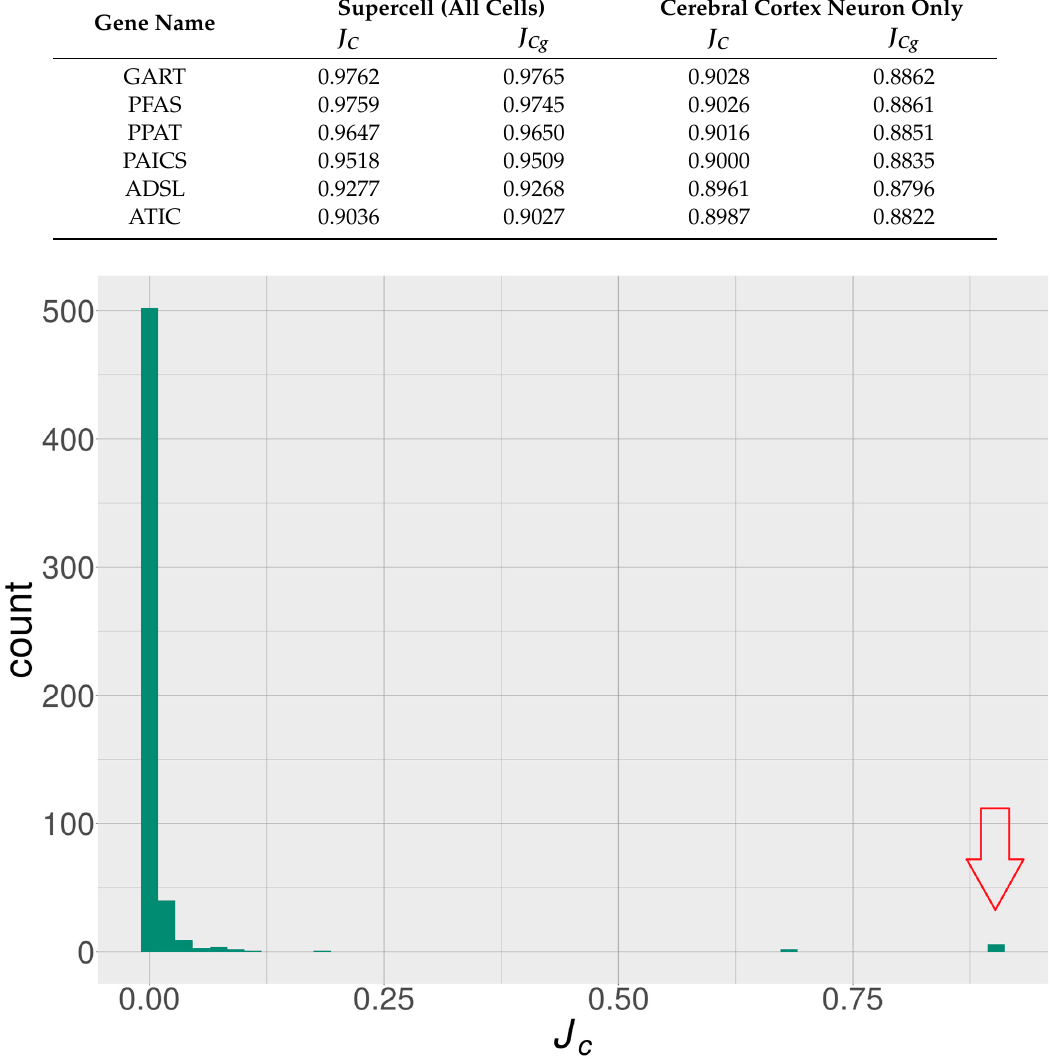
Figure 2. Distribution of Jaccard coe ffi cient ( J C ) values measuring the similarity between folate deficiency and individual genes with a ‘non-empty’ blocked metabolite set within the Recon 2.2 model. The cluster of six purine-metabolism genes mentioned in the main text is indicated by an arrow.